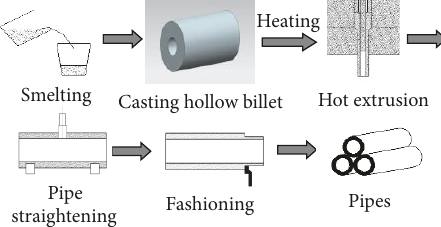
Figure 2: The compact hot extrusion process.